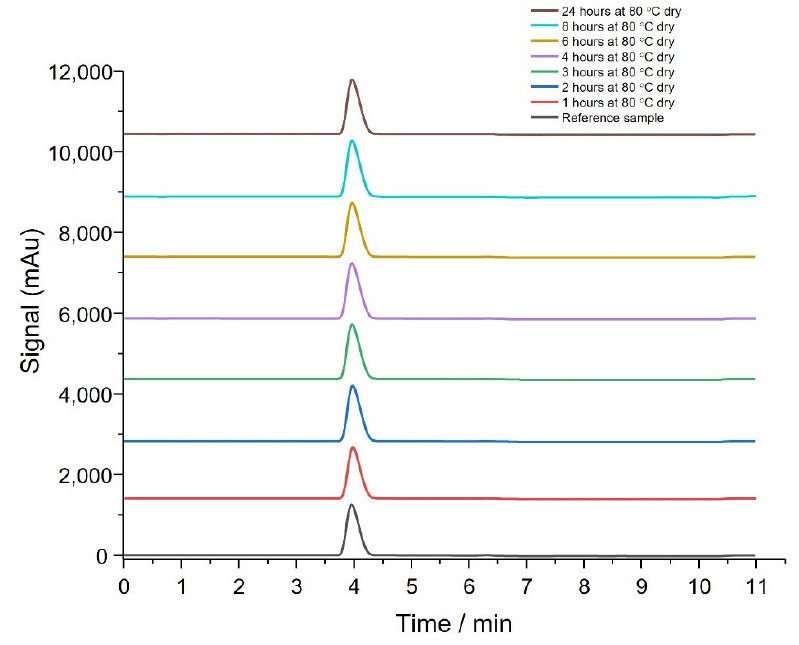
Figure 2. HPLC analysis showing the thymoquinone: hydroxypropyl- β -cyclodextrin was stable after forced heat degradation (dry) ( n = 6).